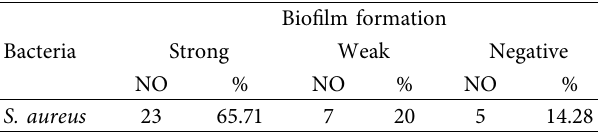
Table 2: Distribution of biofilm-forming strains of S. aureus strains isolated from row cow milk.